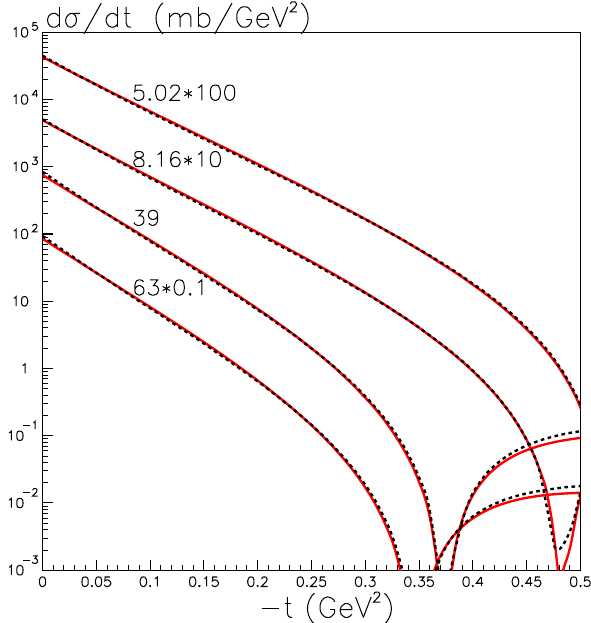
Fig. 3 Elastic proton–proton cross section d σ/ dt at 5,02, 8.16, 39 and 63 TeV (from top to bottom). The predictions calculated within the two- channel model [32] and the one channel eikonal model described in the text are shown by the red and dashed black lines, respectively. In both cases only the | Im A el | 2 contribution to d σ/ dt is shown